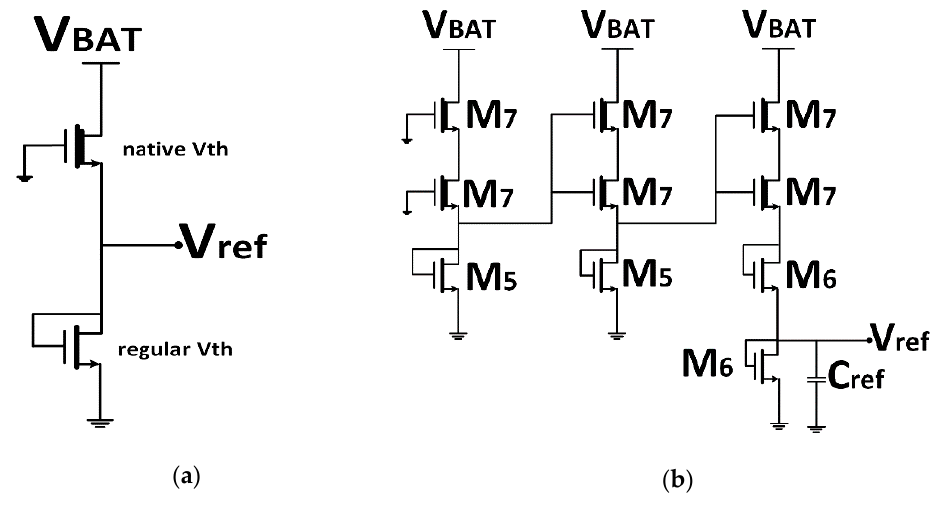
Figure 8. V ref schematic view of: ( a ) 2T proposal from [39] and ( b ) implemented proposal.